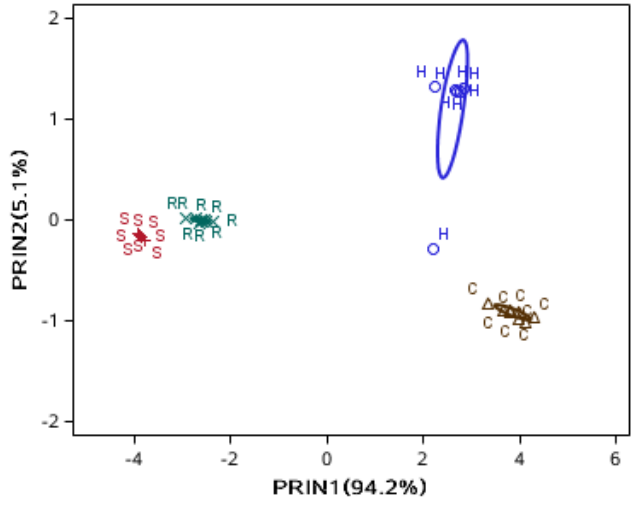
Figure 2. PC1 and PC2 score plot from PCA analysis for four oil samples. H: Hot-pressed sesame oil; C: Cold-pressed sesame oil; R: Refined sesame oil; S: Refined soybean